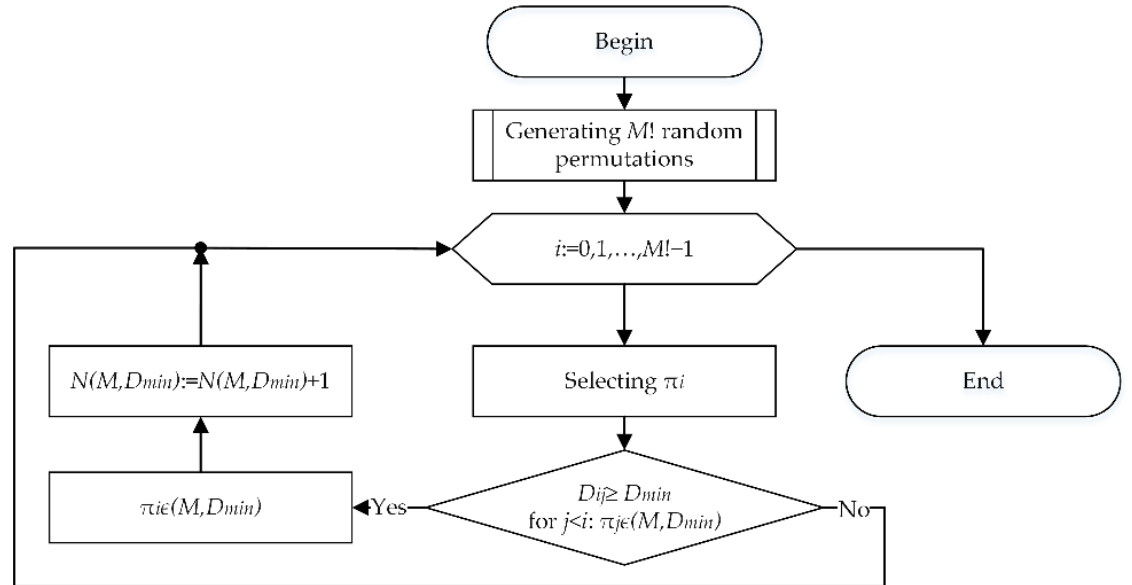
Figure 1. Algorithm to generate a set of codewords.